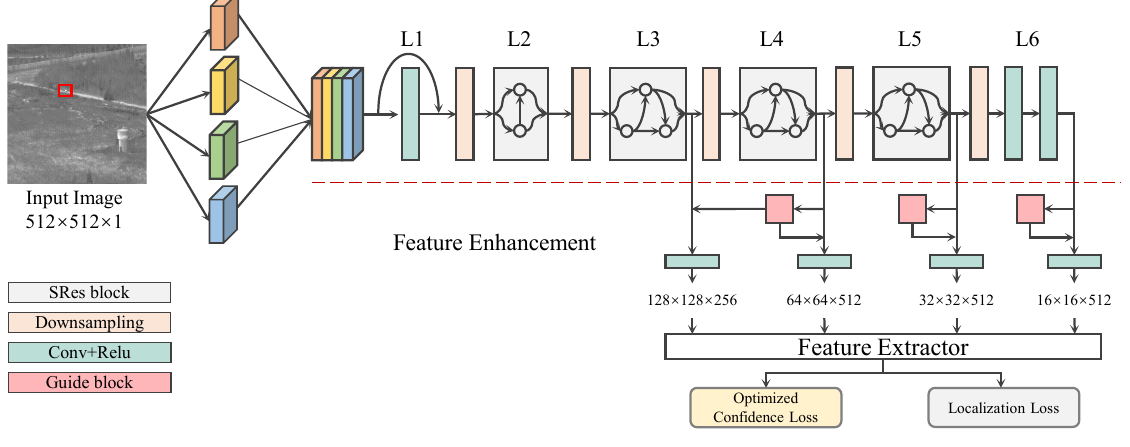
Figure 1. Proposed infrared small-object detection framework. The backbone has 16 weight layers, and L2–L5 layers have 2, 3, 3, 3 SRes blocks. The first layer of the backbone is a parallel convolutional layer with different atrous